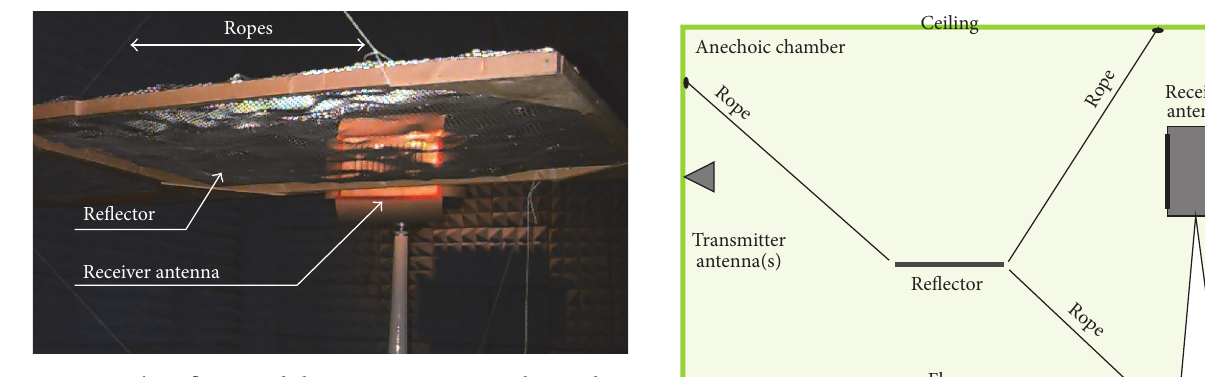
Figure 3: The reflector and the receiver antenna in the anechoic chamber. Photo from [13].